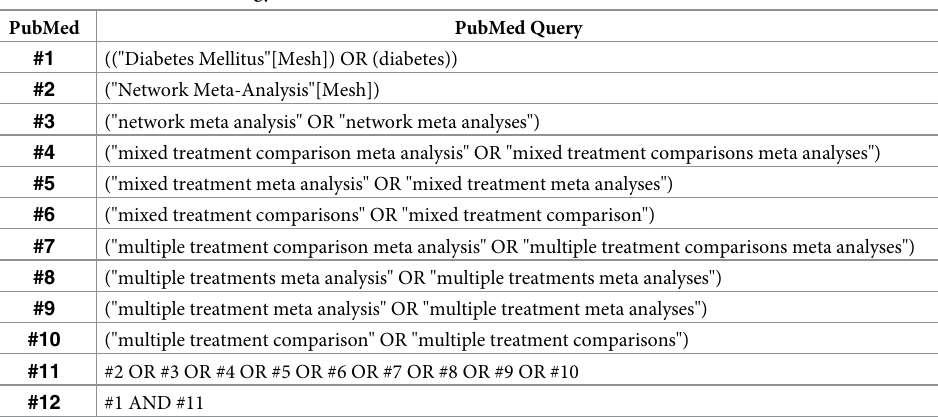
Table 1. PubMed search